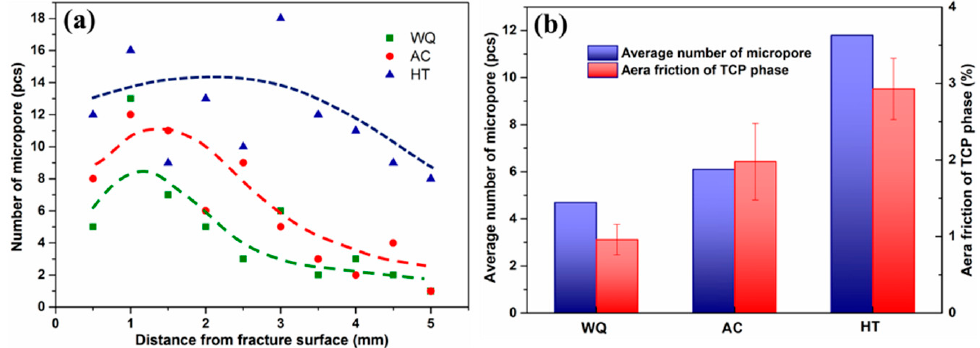
Figure 15. SEM micrographs of different samples ruptured after creep deformation at 1100 °C/137 MPa: ( a ) WQ sample, ( b ) HT sample, ( c ) TCP phases near homogenization pores, ( d ) TCP phases near the creep deformation pores and microcracks and ( e , f ) growth of pores and microcracks.